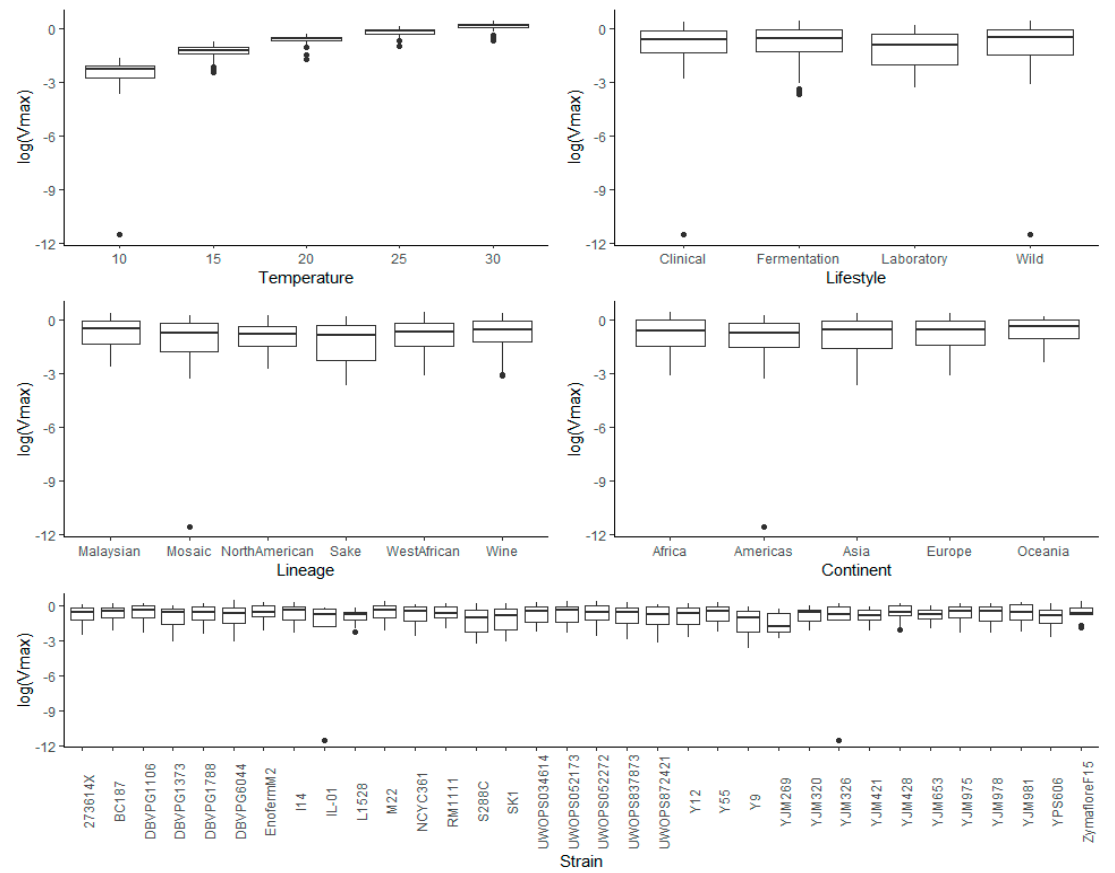
Figure 5. Box plots exploring the relationships between the log-transformed V max and each of the factors explored in this investigation (temperature, lifestyle, lineage, continent, and strain).